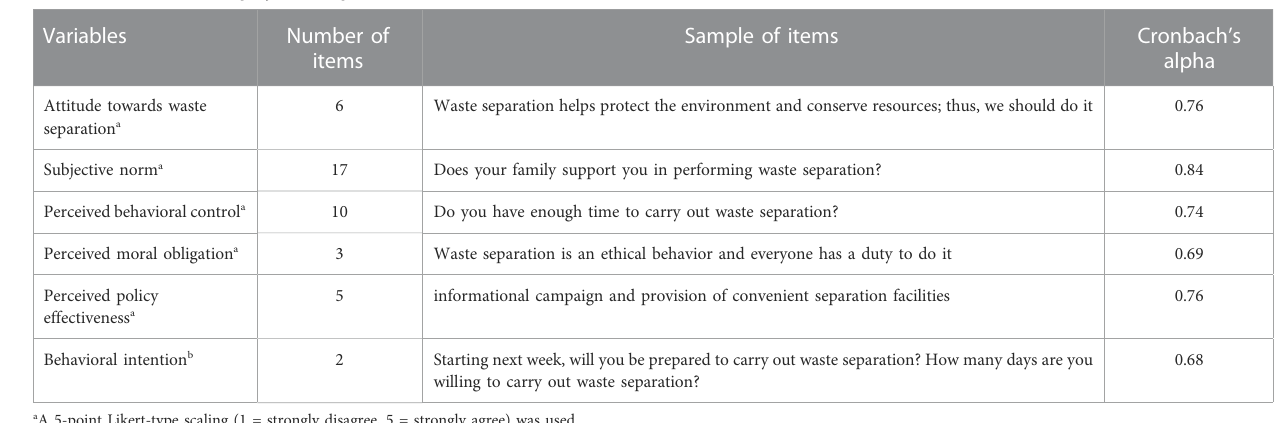
TABLE 1 Details of the employed TPB